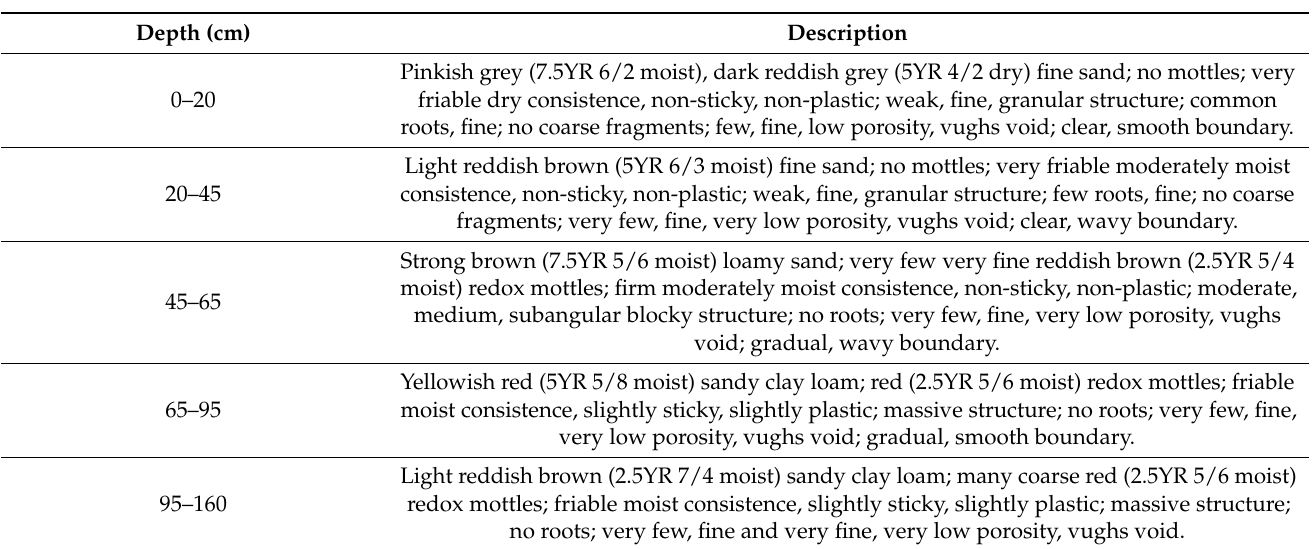
Table 2. Soil profile description for a typical deep sand profile from Boeng Tuk commune, Kampot Province, Cambodia. Classified as similar to Prey Khmer Soil Group [12] and Plinthic Alisols [23]. Described by: Sarith Hin, 16 December 2008; Location: Datum: IND60 Zone: 48 404320 mE 1167649. Elevation: 15 m asl on a low-gradient